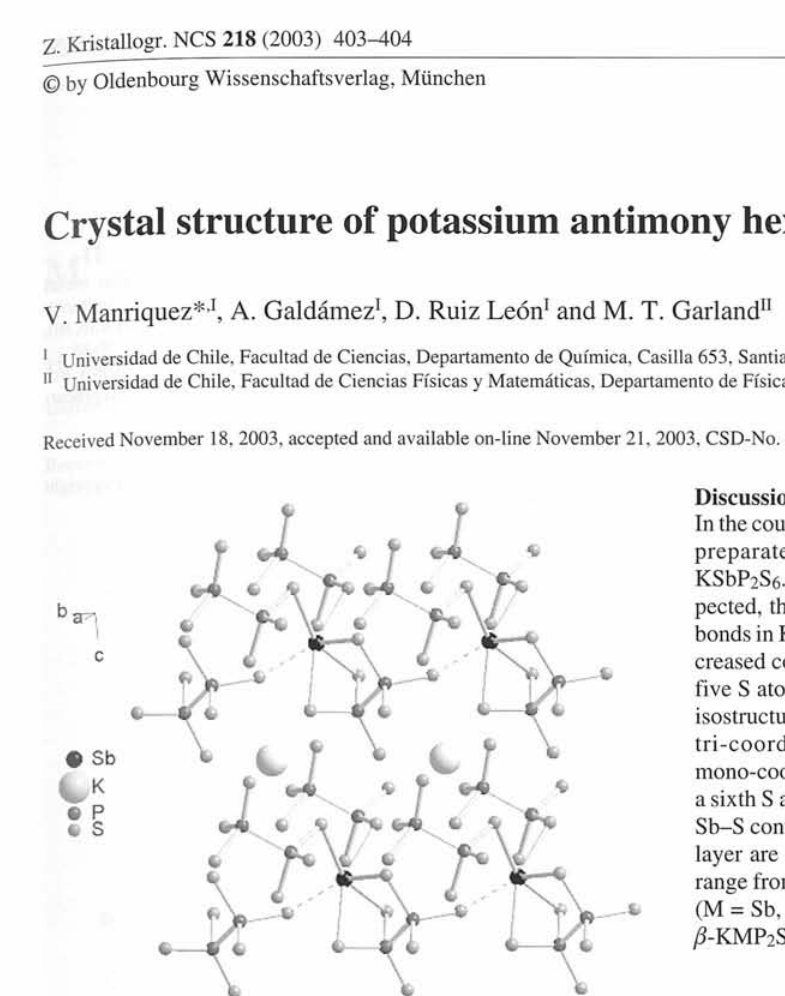
Table 1. Data collection and handling.